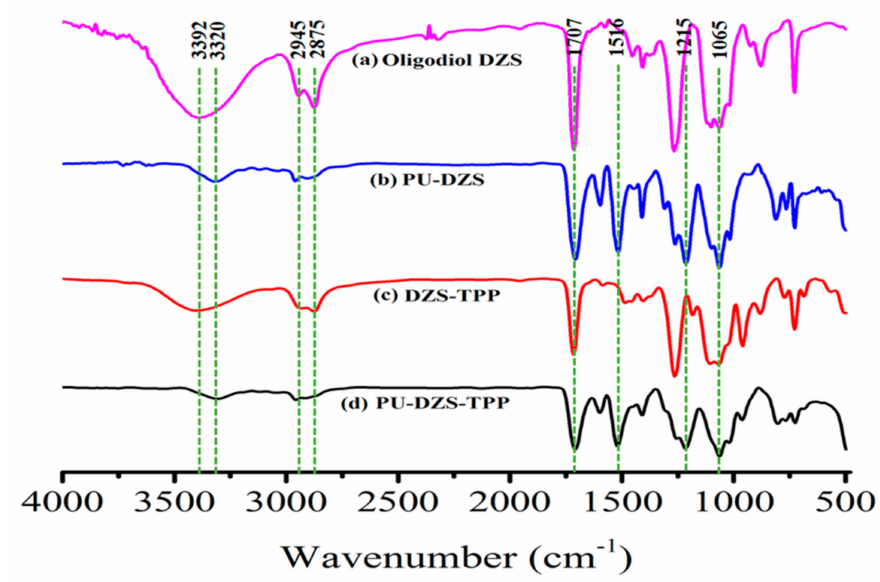
Figure 1. FTIR-ATR spectra of ( a ) oligodiol DZS; ( b ) polyurethane prepared from DZS and MDI; ( c ) a mixture of DZS and TPP (25 pph); and ( d ) polyurethane prepared from DZS, TPP and